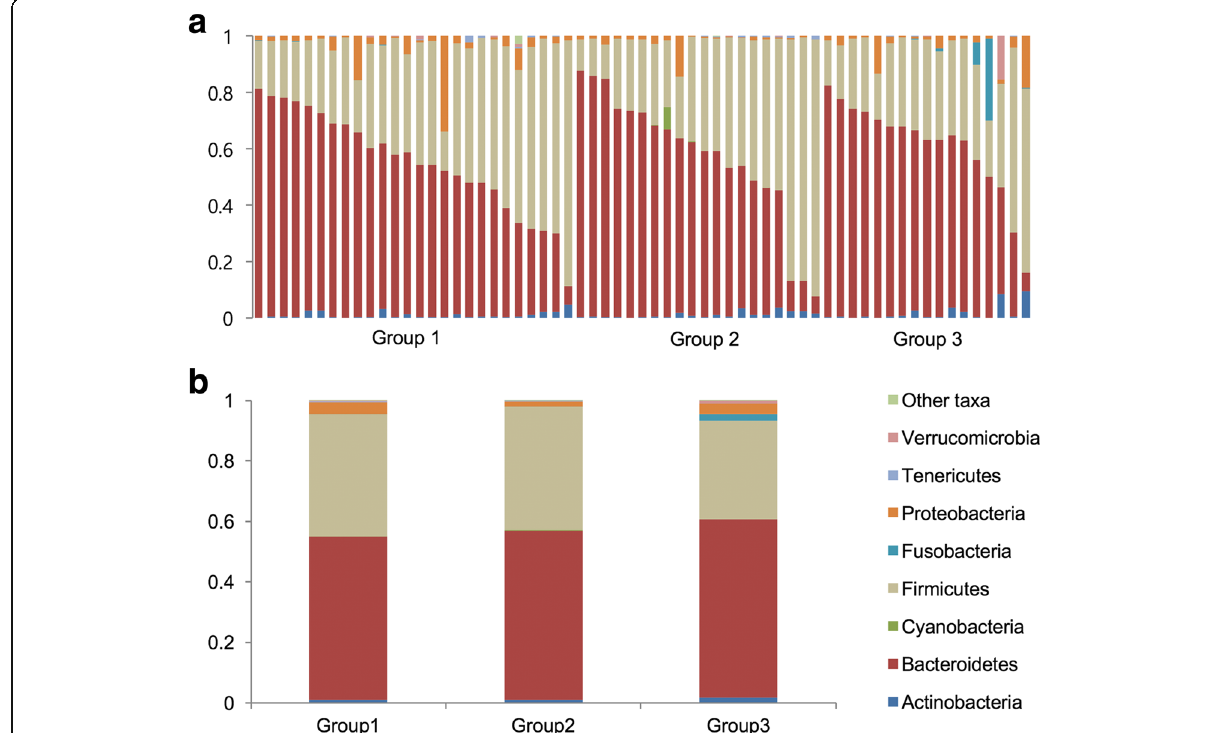
Fig. 2 Relative abundances of microbial phyla in each subject ( a ) and group ( b ) (group 1; n = 26, group 2; n = 20, group 3; n = 17) (Most abundant eight phyla were demonstrated according to the phylum